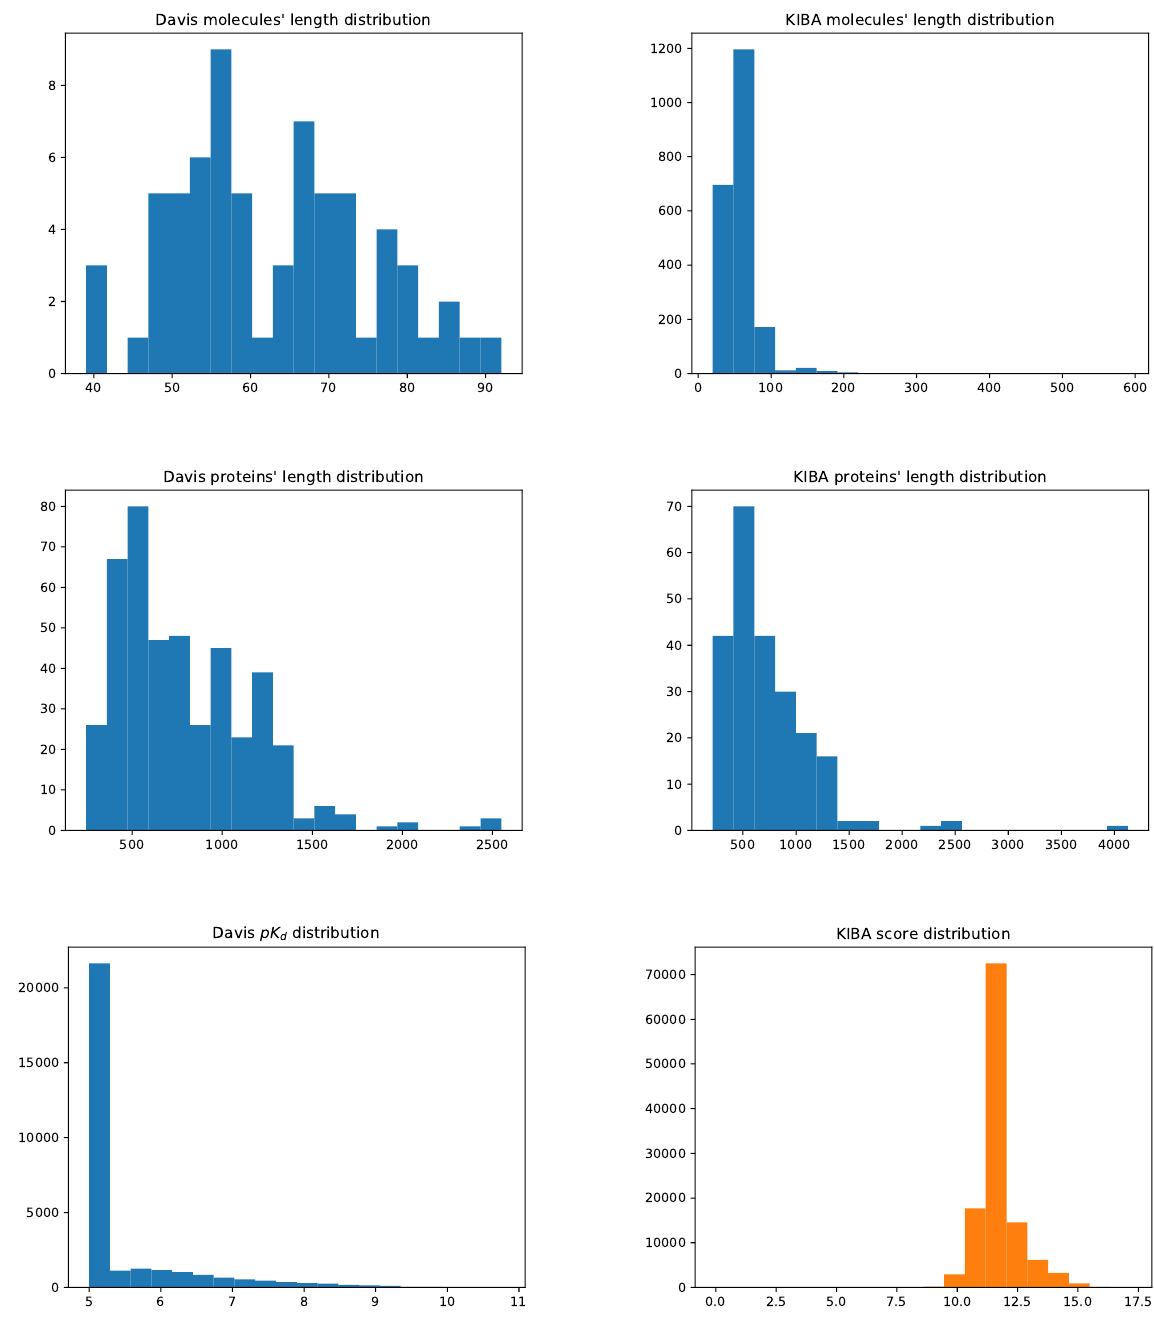
Figure 8. Summary of the Davis ( left ) and KIBA ( right ) datasets. The first row shows the distribution of the molecules’ length representation in SMILES. The second row shows the distribution of the proteins’ sequence length. The third row shows the distribution of binding a ffi nity values, respectively, pK d and KIBA